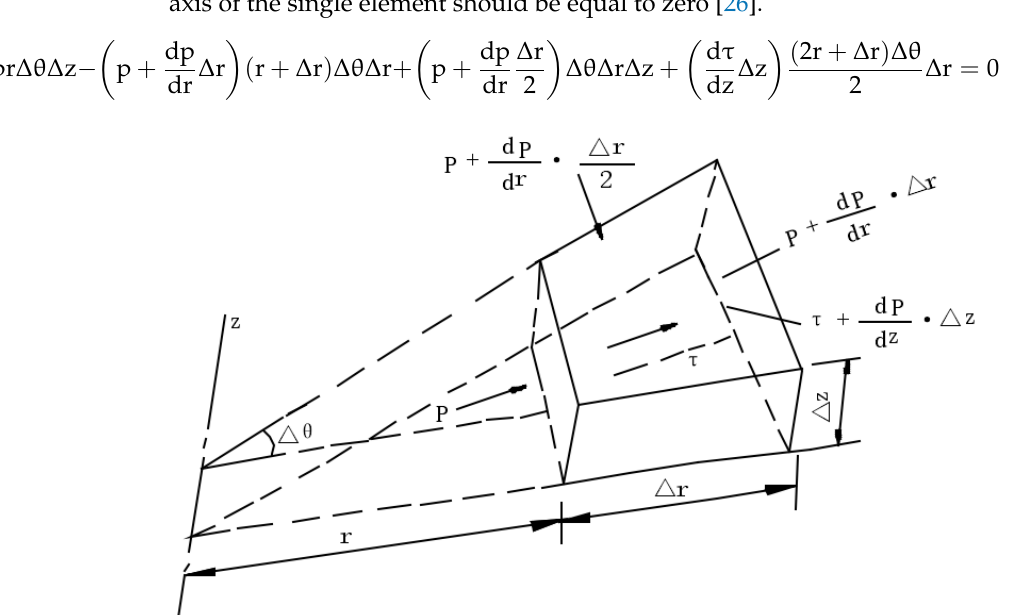
Figure 4. D etermination of slurry unit. Figure 4. Determination of slurry